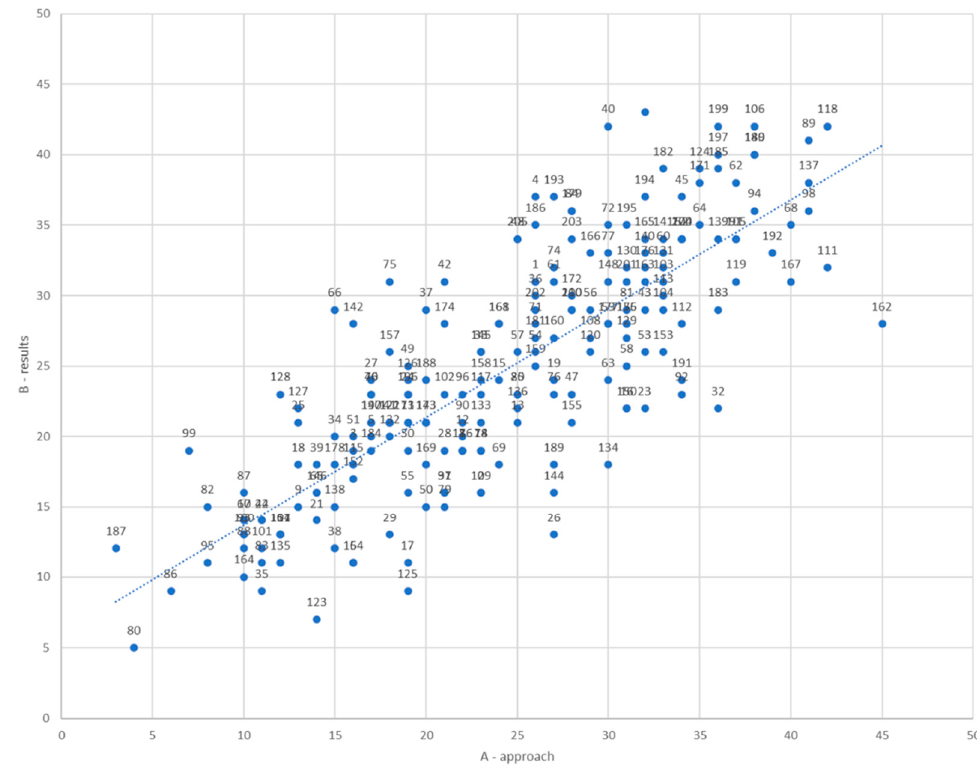
Figure 3. A scatter diagram showing sums for Approach (A) and Results (B) (N = 205).